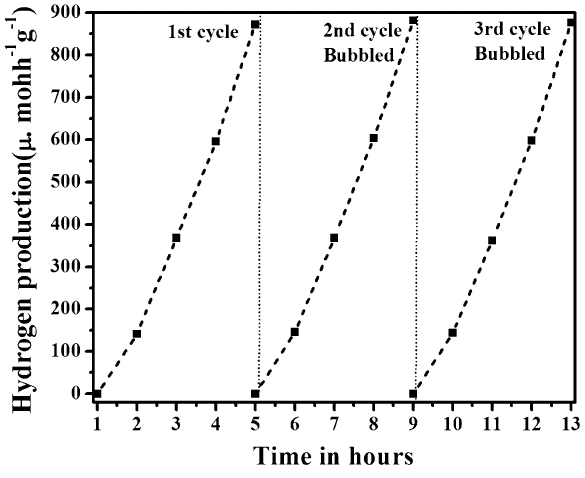
2 and MoS 2 heterojunction inter-